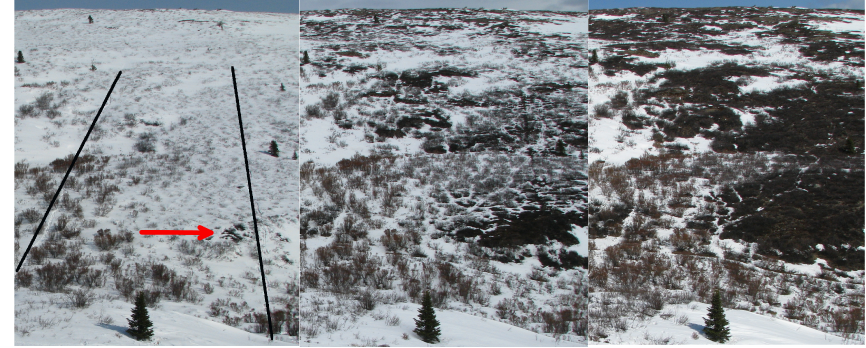
Figure 9. Area surrounding the two easternmost transects on the southwest-facing slope on 20 April, 27 April and 3 May 2008 from left to right. The visible portion of the transects is approximately 200m long. The red arrow is pointing to a snow-free patch.